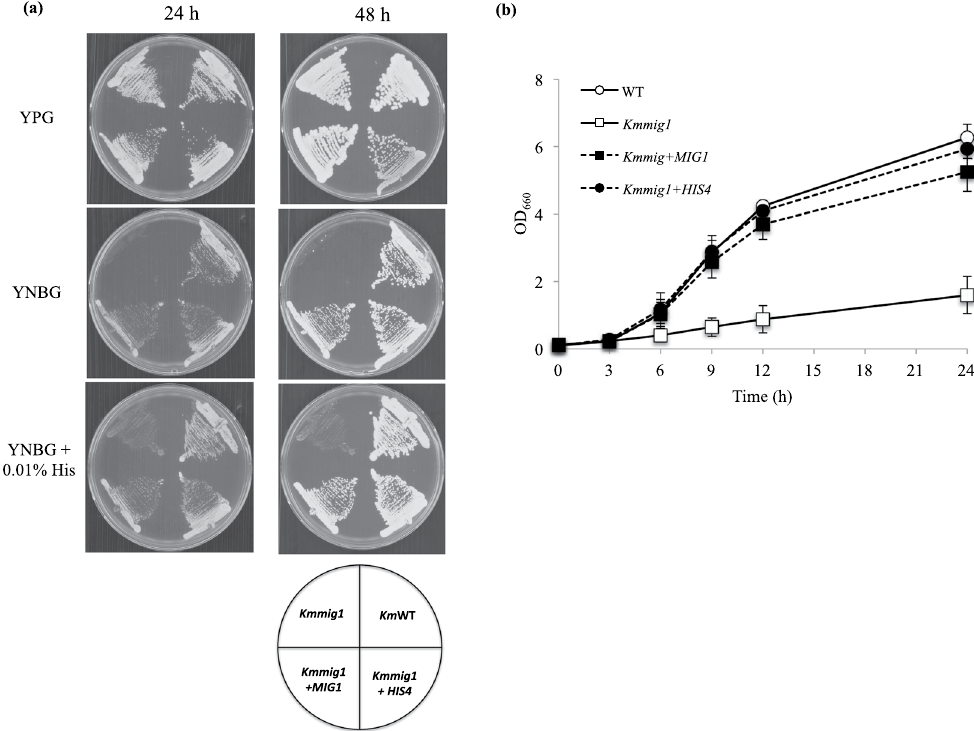
Figure 3. Complementation experiments by increased expression of HIS4 under control of the S . cerevisiae TDH3 promoter in Kmmig1 . Cells were pre-cultured in 5 ml of YPG at 30 °C under a shaking condition at 160 rpm for 15–18 h. ( a ) The cells were streaked on plates of YNBG, YNBG supplemented with 0.01% ( w/v ) histidine and YPG as a control. The plates were incubated at 30 °C and photos were taken at 24 h and 48 h. ( b ) The pre-cultured cells were inoculated in 100 ml of YNBG and 0.01% ( w/v ) histidine at the final OD 660 of 0.1 and cultivated at 30 °C under a shaking condition at 160 rpm for 24